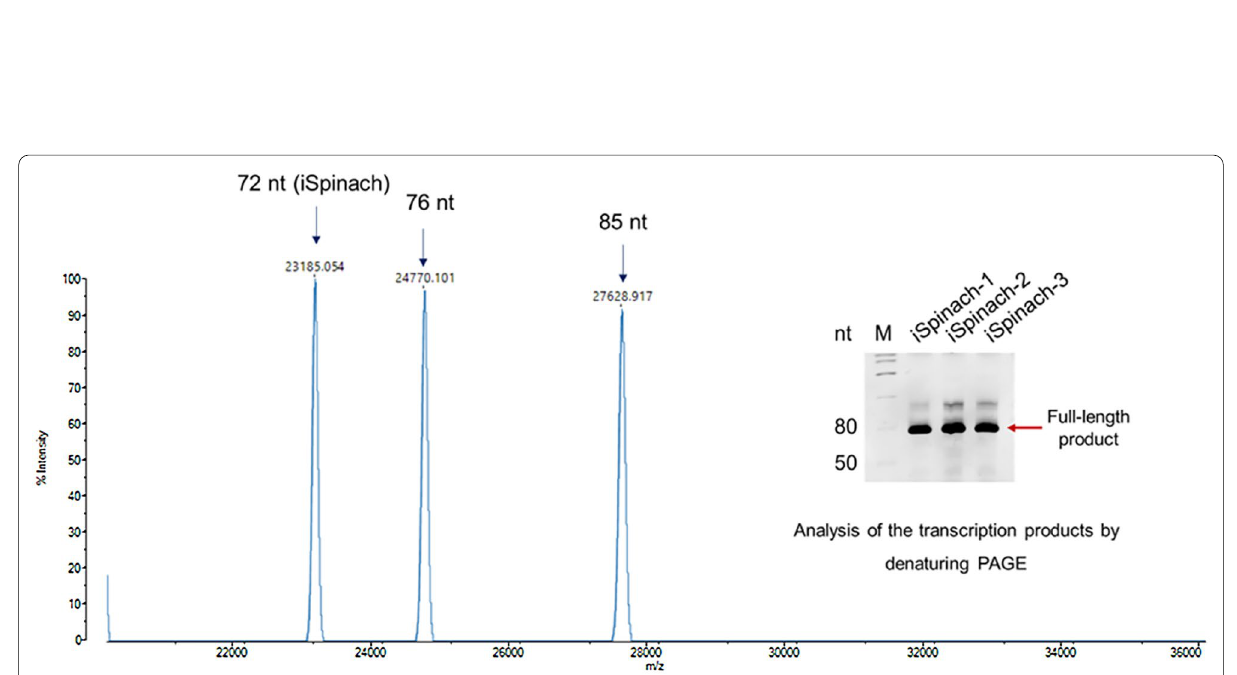
Fig. 2 Analysis of iSpinach transcripts by denaturing polyacrylamide gel electrophoresis and nucleic acid mass spectrometry. M represents RNA marker. iSpinach‑1, iSpinach‑2, and iSpinach‑3 represent three different